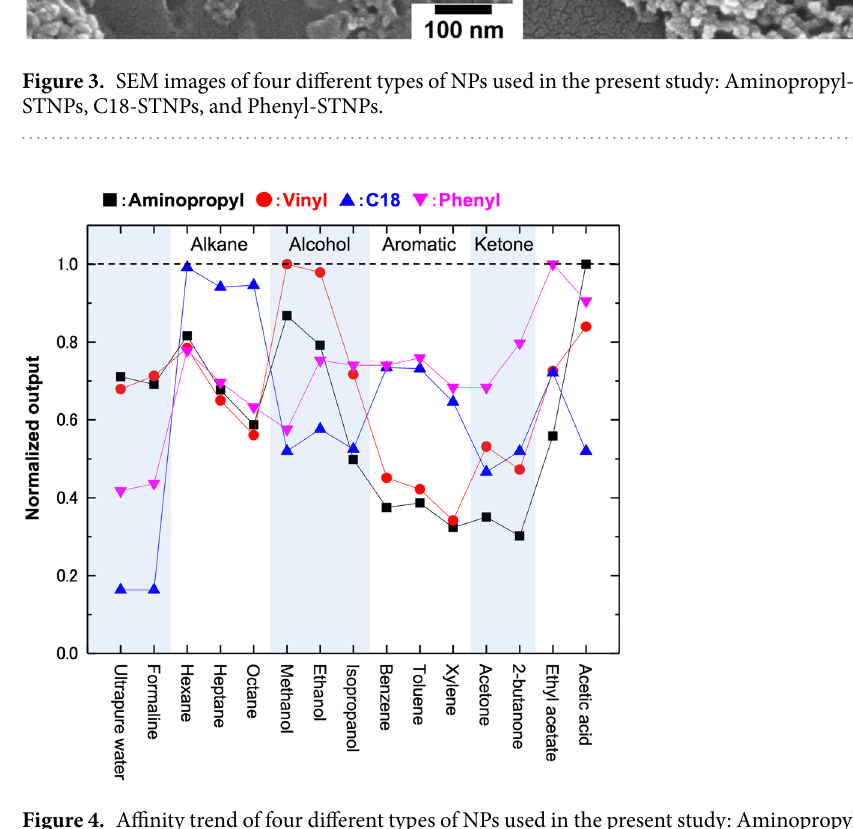
Figure 4. Affinity trend of four different types of NPs used in the present study: Aminopropyl-STNPs, Vinyl- STNPs, C18-STNPs, and Phenyl-STNPs. The normalized output used in this figure was defined on the basis of the signal intensity of the third response cycle shown in Figure S2 (the first and second responses were omitted to get reproducible responses because the initial instability was observed in the first two